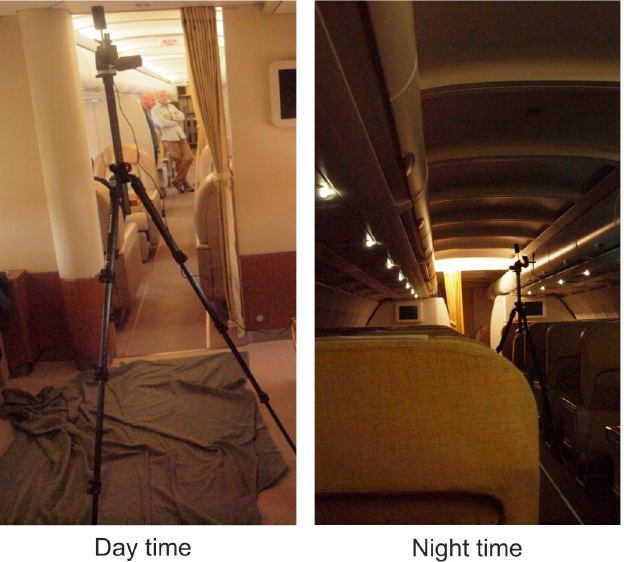
Figure 15. Results of measurement of illumination in the Airbus A-319CJ interior.